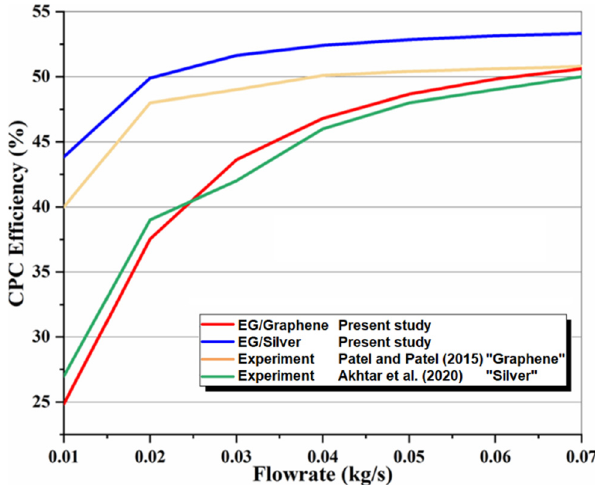
Figure 2. Comparison of effect of nanoparticle volume concentration on nanofluid thermal conduc- tivity with experimental studies [48,49].